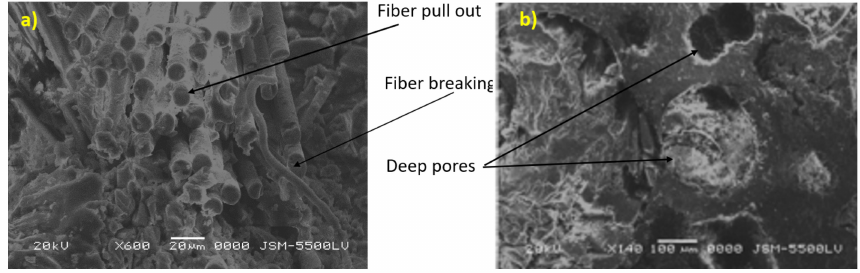
Figure 9. ( a , b ) SEM examination of fracture surface in the tension test specimen .